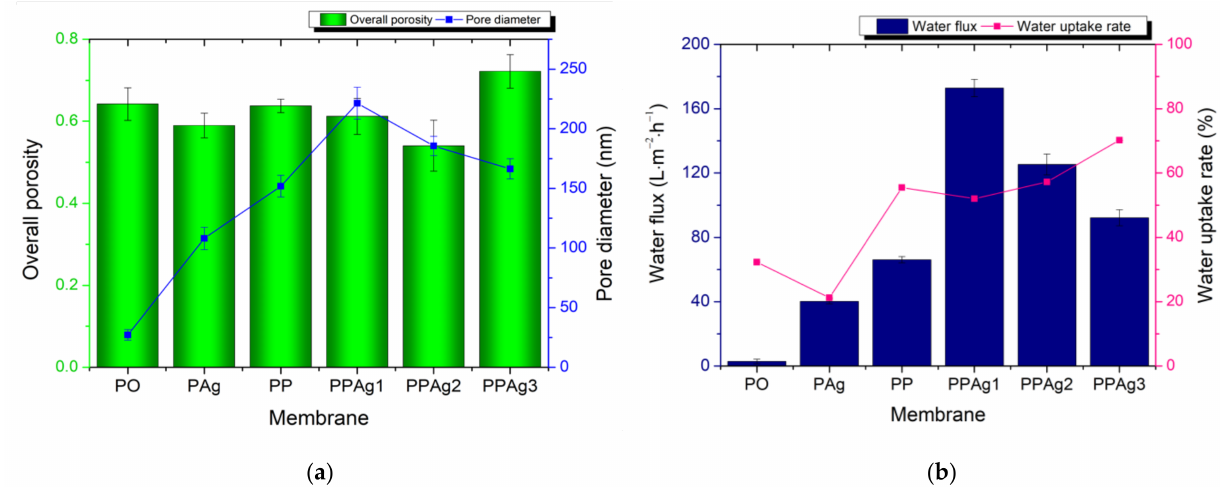
Figure 7. Membrane porosity and pore diameter ( a ); water uptake rate and clean water flux ( b ).